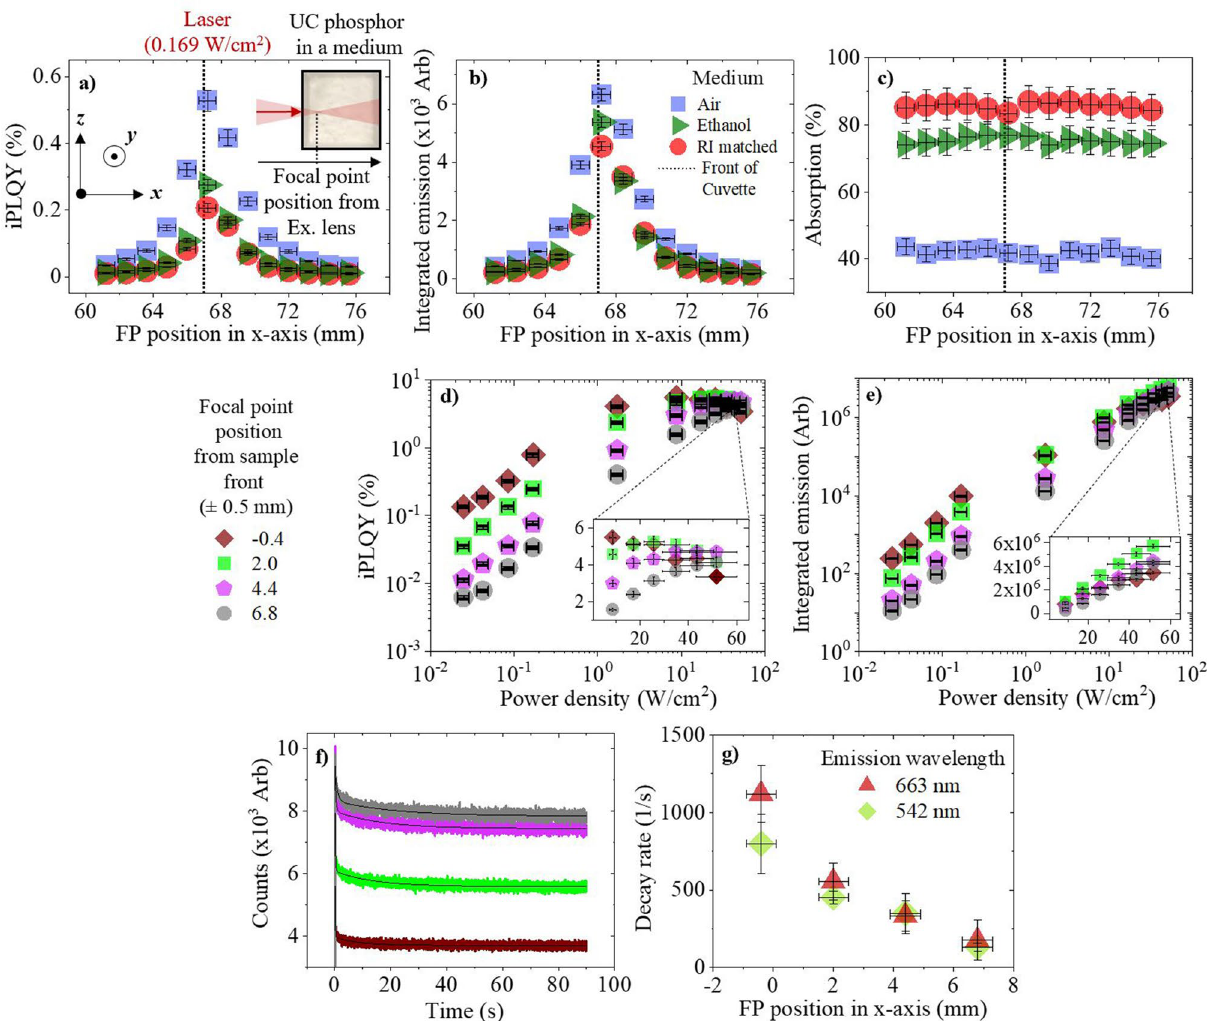
Figure 4. β-NaYF 4 :(18%)Yb 3+ ,(2%)Er 3+ phosphor is excited with a 980 nm laser diode, the FP of which, is moved through the sample in the x-axis. The phosphor is air (blue square), ethanol (dark green triangle), or a RI matched medium (red circles). The following is measured against the FP position from the excitation lens: ( a ) iPLQY (500–700 nm), with an inset depiction of the excitation conditions inside each sample, ( b ) integrated emission (500–700 nm), and ( c ) absorption. The second experiment investigates moving a high PD regime, where the FP is moved to four positions: − 0.4 (rotated brown square), 2 (light green square), 4.4 (pink pentagon), and 6.8 ± 0.5 mm (grey circle), relative to the front of the cuvette. At various FP positions through the sample, the following is presented against excitation PD: ( d ) iPLQY (500–700 nm), with an inset magnification of results at the highest PDs, and ( e ) the integrated emission (500–700 nm), with an inset magnification of the results at the highest PDs. The third experiment investigates excitation induced thermal effects at various FP positions. At various FP positions through the sample, the following is obtained: ( f ) the 542 nm emission decay versus excitation time, and ( g ) the 542 nm (rotated green square) and 663 nm (dark red triangle) emission decay rate versus FP